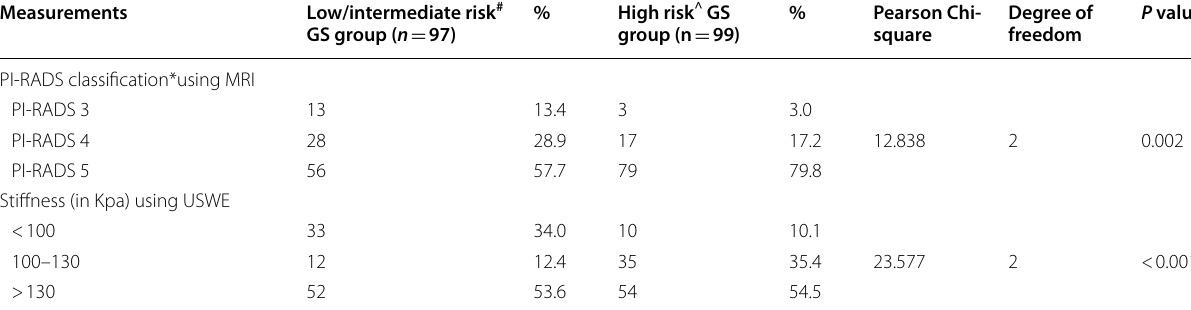
*PI-RADS classification 3 means intermediate probability of clinically significant prostate cancer, 4 means high probability and 5 means very high probability of clinically significant prostate cancer; # Gleason score 3